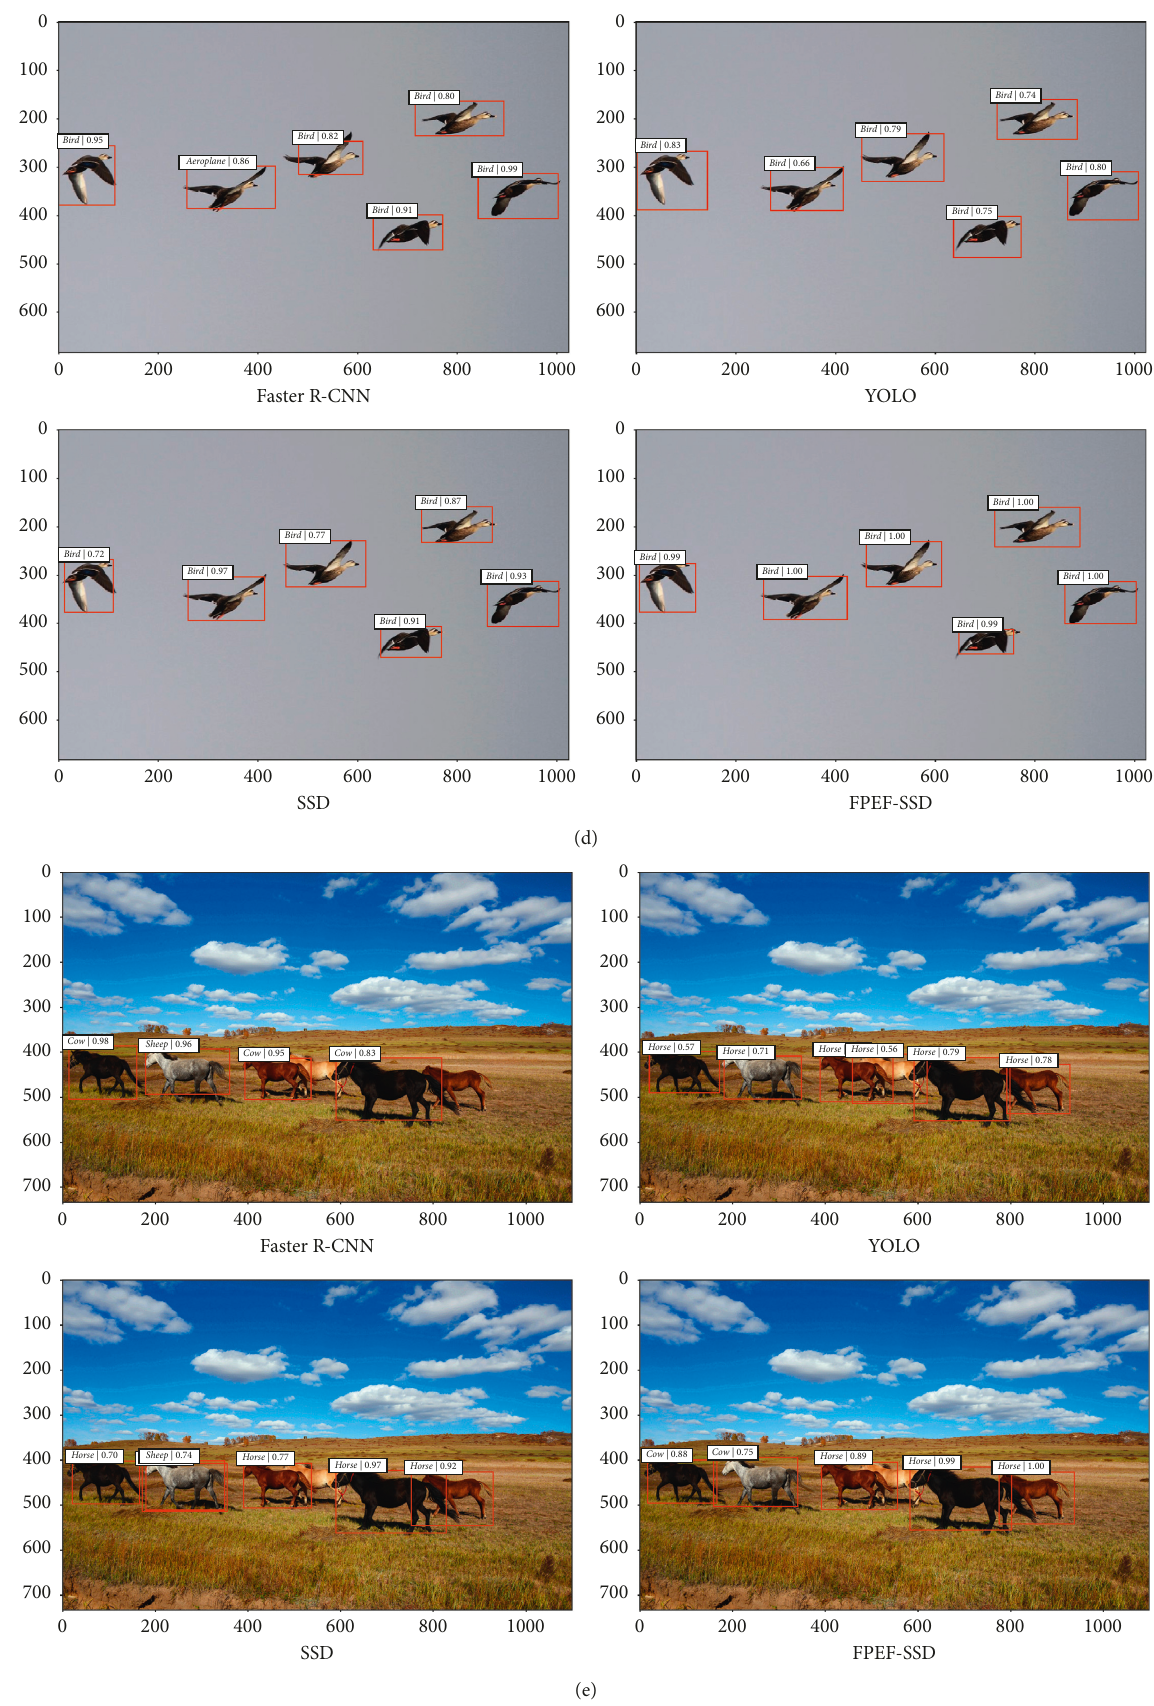
Figure 5: Comparison of results of different